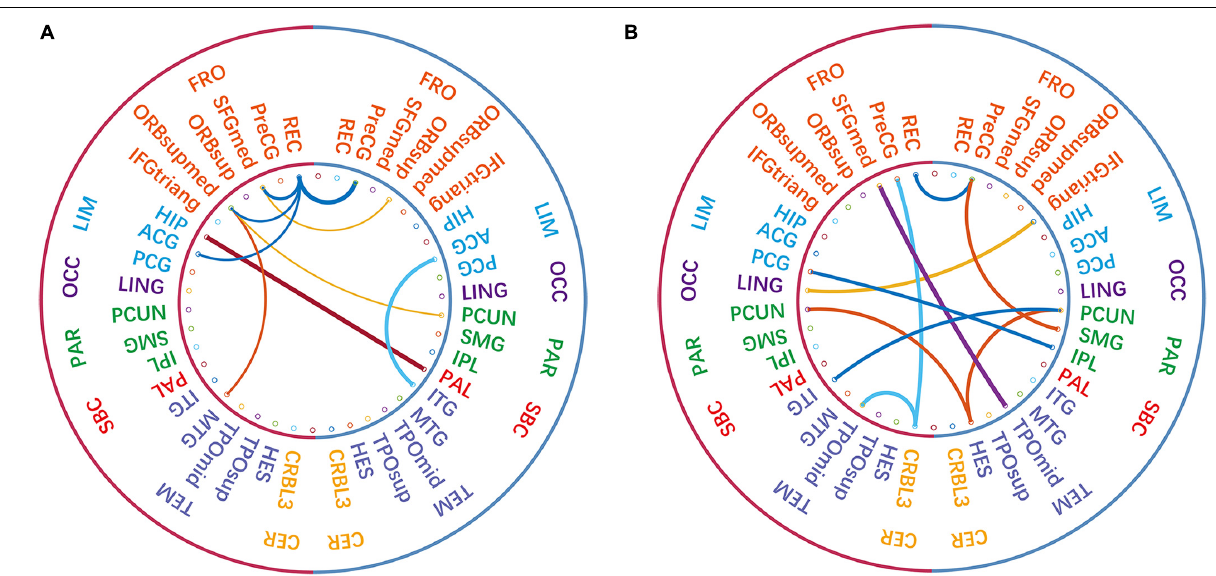
FIGURE 10 | The comparison of the most discriminative features in the “hierarchical sub-network method” (A) and the “fully-network FCN method” (B) . The left-side of each diagram represents the left hemisphere of the brain, and the right-side represents the right hemisphere of the brain. In the inner circle, each line connects two ROIs, and the thickness of the line represents the strength of its identification